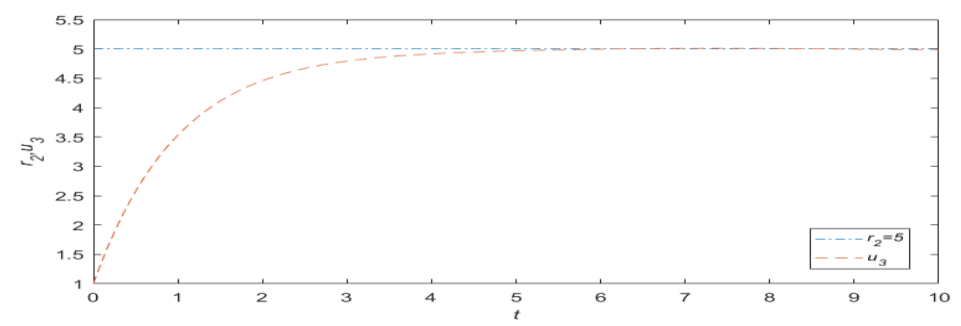
Figure 2. Tracking sine function.